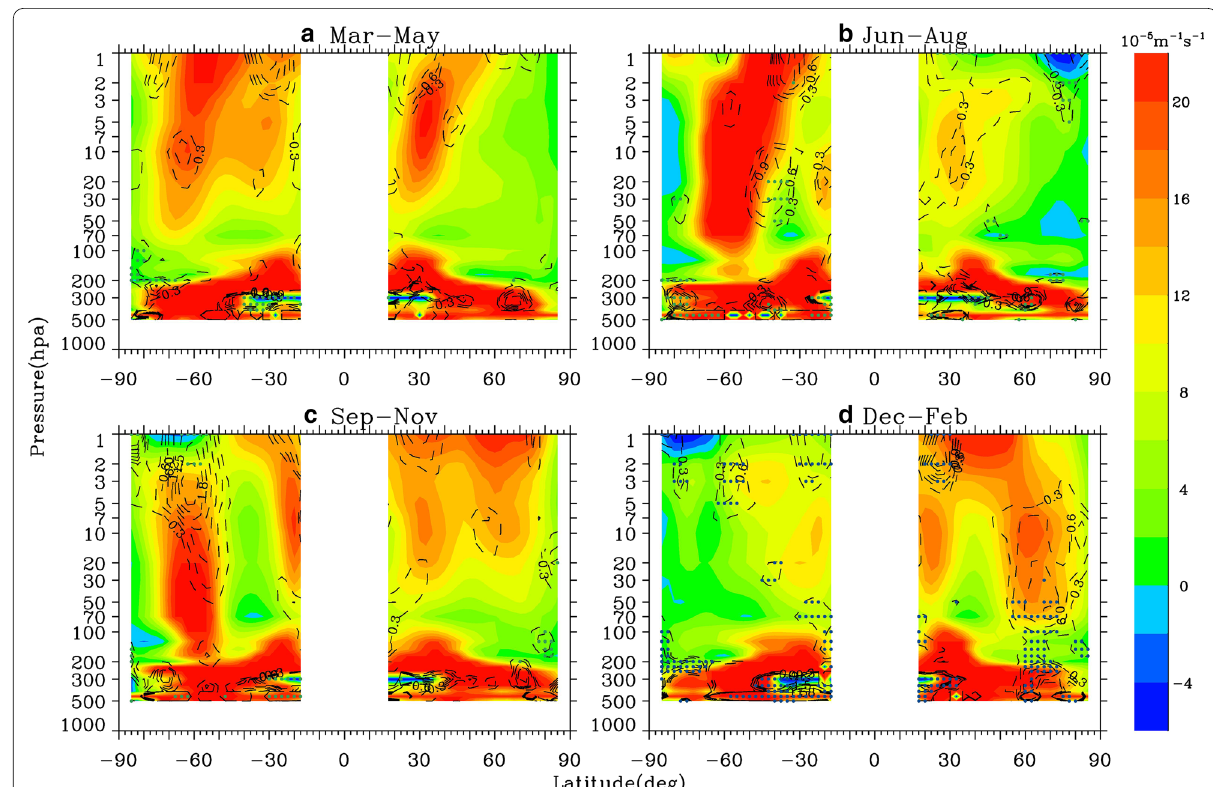
Fig. 10 Trend (contours, units: 10 –5 m –1 s –1 /decade) of the monthly mean ¯ q (cid:31) in four seasons. The dashed contours denote the negative trend. The stippled regions represent the trends at/above 95% confidence level. The colors represent the climatological mean of seasonal ¯ q